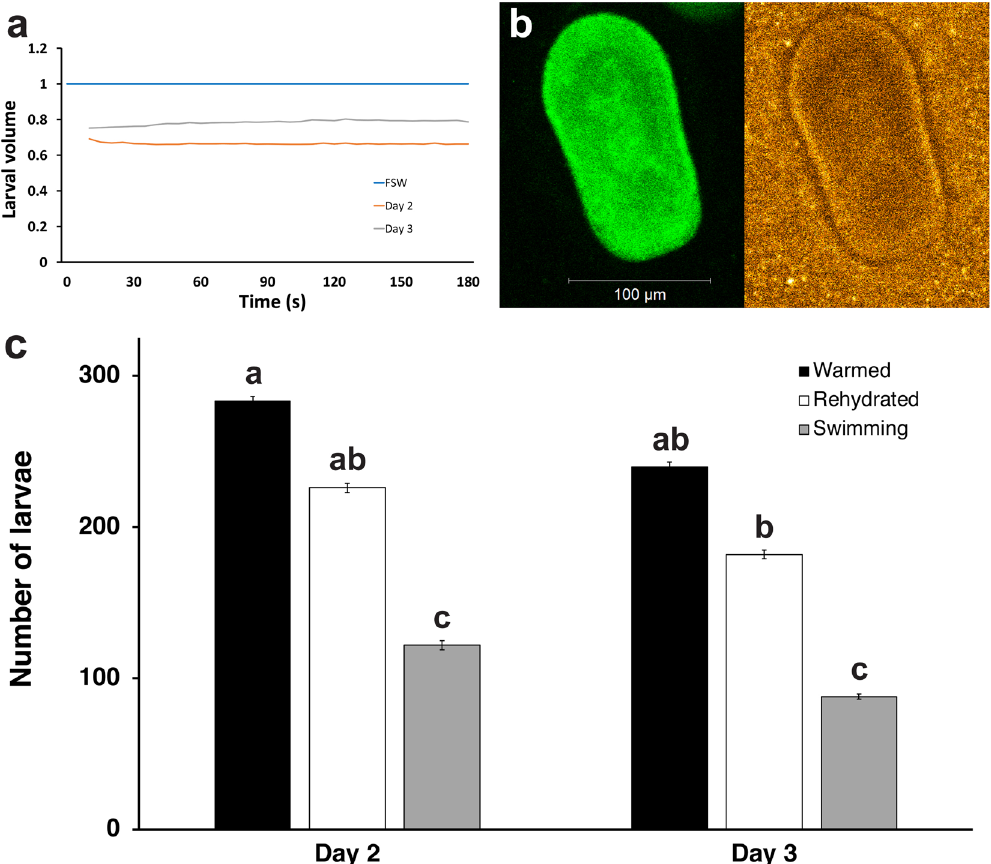
Figure 4. Dehydration of larvae in response to complex cryoprotectant solutions reduced internal ice crystal formation during vitrification and even distribution of the gold nanorod particles permitted reproducible melting of 1- µ L vitrified droplets, resulting in live F. scutaria larvae post-warming. ( A ) Changes in larval volume in response to cryopreservation solution 2 (5% v/v DMSO, 10% v/v PG, and 1 M trehalose in PBS) in larvae from Day 2 and Day 3 post-fertilization. Dehydration was more effective on Day 2 than on Day 3, which may account for the higher rate of larval recovery on that day. Volumes are expressed as a proportion of the mean larval volume in FSW for a given day, and each data point is a mean of n ≥ 10 measurements. ( B ) Confocal images of a Day 3 larva showing fluorescence from GFP (left) and distribution of DyLight-coated gold nanorod particles surrounding the larva in cryoprotectant (right). Gold nanorod particles were evenly distributed in the cryoprotectant solution and formed a dense field that completely surrounded the larvae. ( C ) Total number of Day 2 and Day 3 larvae that were vitrified and laser warmed (black), compared to the number remaining after rehydration (white), and the number that resumed swimming (grey). The number of larvae that survived rehydration and resumed swimming was reduced on Day 3 compared to Day 2 but this was not significant. Data are mean ± SEM. Columns with the same letter are not significantly different ( P > 0.05, Kruskal-Wallis test with Dunn’s multiple-comparisons